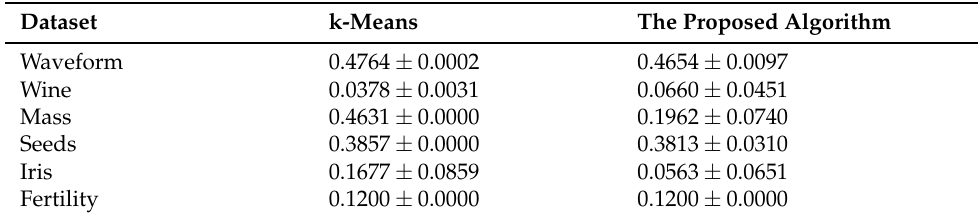
Table 5. Comparison of the proposed algorithm with k-means on numerical datasets.